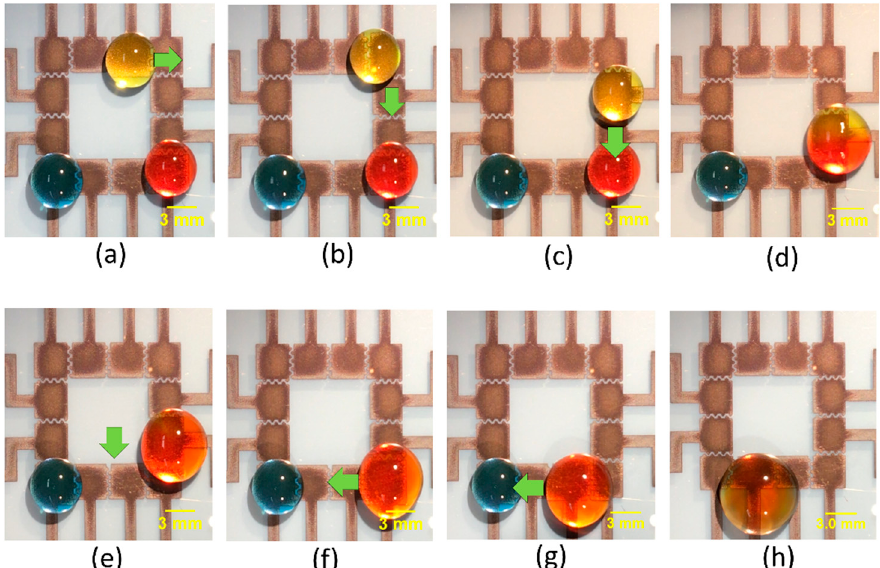
Figure 4. Sequence of images showing the motion and mixing of droplets on the FINP-DMF platform with interdigitated electrode design (design C). ( a ) Position of yellow, red and blue droplets at time (t) = 3.6 s. Initial volume of all droplets is 30 µ L. ( b ) Position of droplets at t = 3.7 s. ( c ) Position of droplets at t = 4.9 s. ( d ) The yellow droplet moves towards the red droplet and starts merging with it (t = 5.7 s). ( e ) Yellow and red droplets mix with each other to yield a single droplet (t = 23.9 s). ( f ) The yellow–red droplet mixture then moves towards the adjacent electrode (t = 24.2 s). ( g ) Position of the blue droplet and yellow–red mixture droplet at t = 27.6 s. ( h ) The yellow–red droplet mixture moves towards the blue droplet and mixes with it (t = 37.1 s).